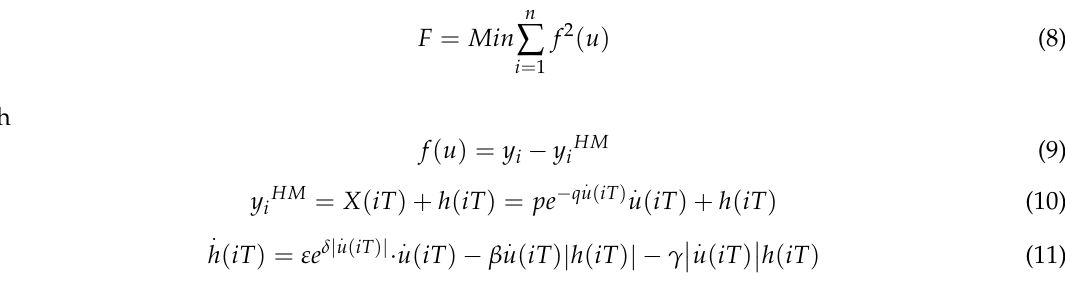
Figure 4. Variations of the component X ( t ) under u ( t ) = 5sin ( 2 π ft ) + 5: ( a ) f = 10 Hz; ( b ) f = 40 Hz; ( c ) f = 80 Hz.